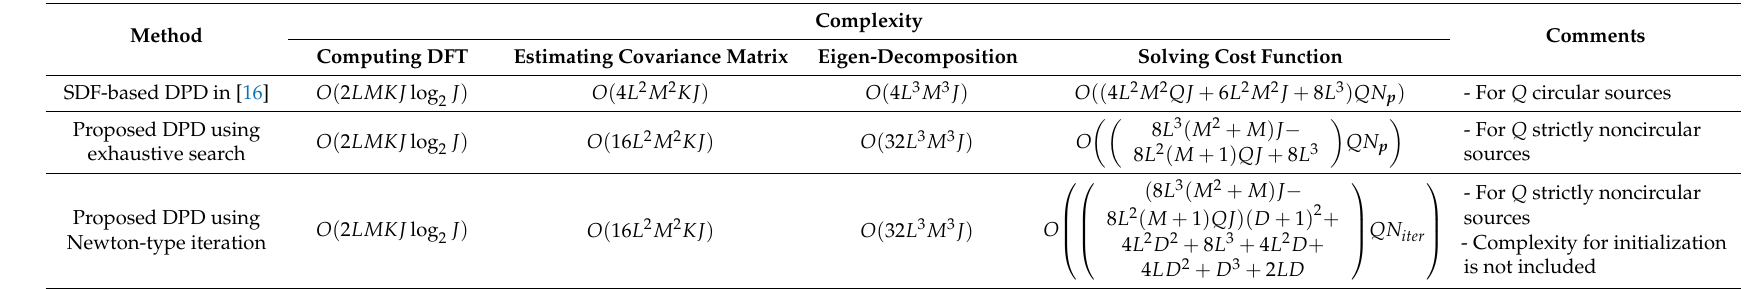
Table 1. Computational